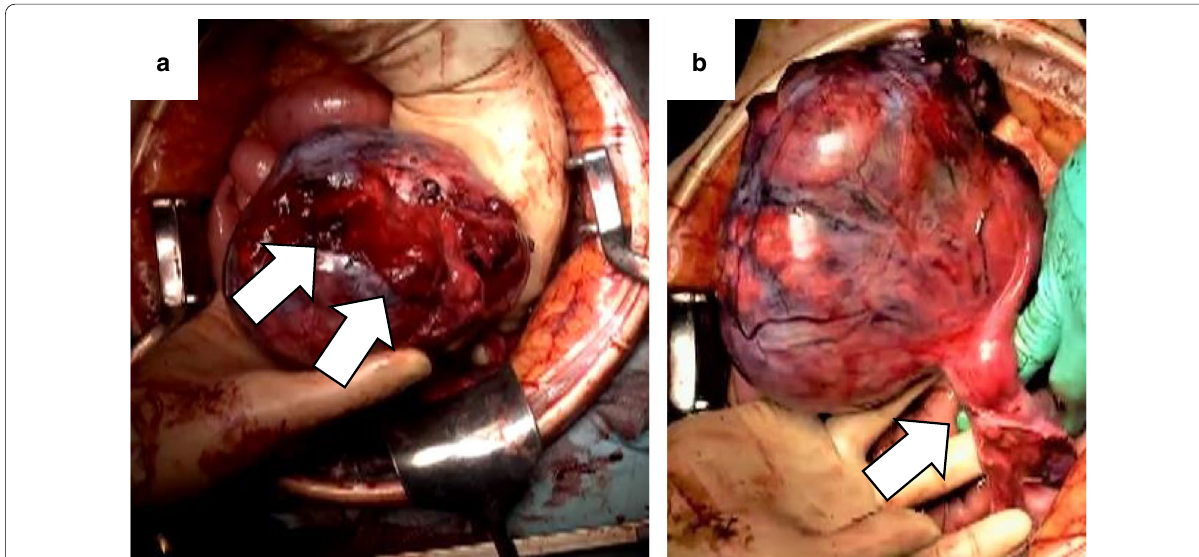
Fig. 3 a Gross photograph of the mass cross-section. Solid tumor covered with a thin capsule showing internal necrosis and hemorrhage. b Tumor cells with large circles are arranged in sheets, with finely vacuolated cytoplasm, and nuclei with distinct nucleoli of the tumor cells are round. Infiltration of lymphoplasmacytic cells is observed (hematoxylin and eosin stain, 400 ×